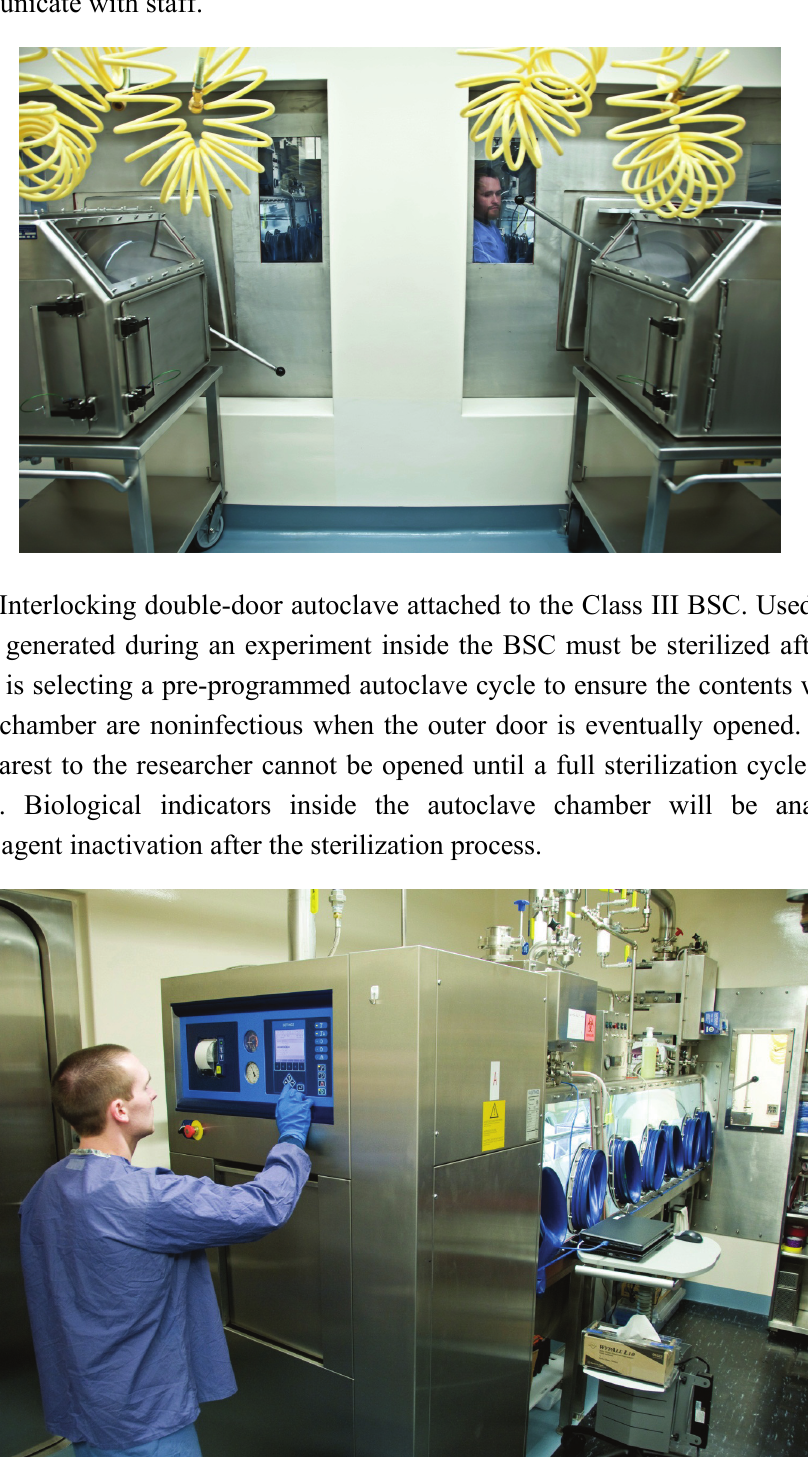
Figure 5. ABSL-4 suit laboratory transport carts. Two specialized transport carts within the ABSL-4 suit laboratory are docked to the Class III BSC at the Rapid Transfer Port. Through windows in the wall between the ABSL-4 suit laboratory and the Class III BSC, researchers see into the adjacent ABSL-4 cabinet laboratory containing the Class III BSCs and communicate with staff.